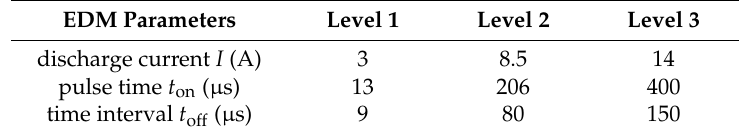
Table 4. The levels of machining parameters carried out in the experimental design.